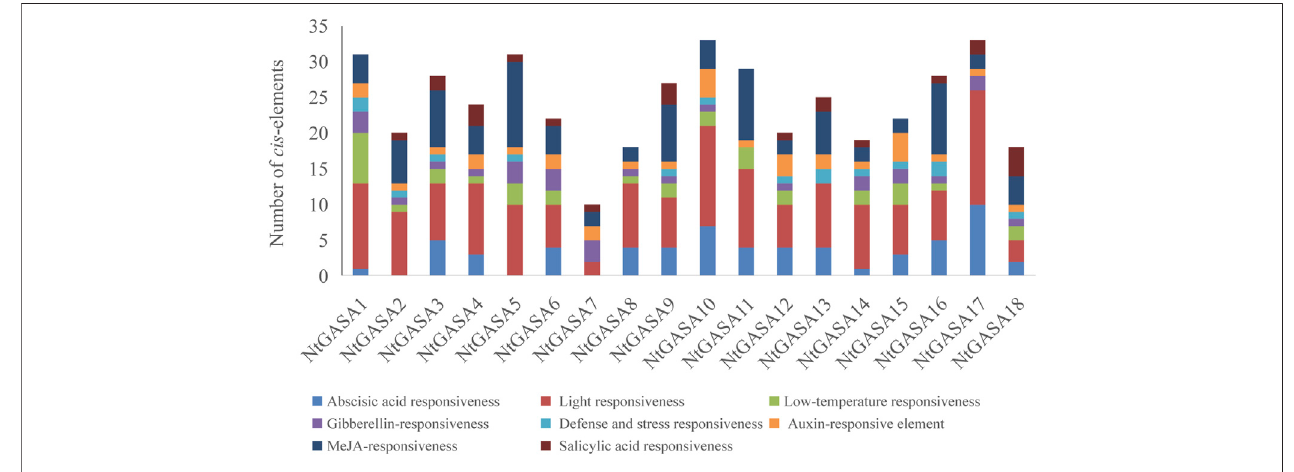
FIGURE 7 | Cis -element analysis in the NtGASA